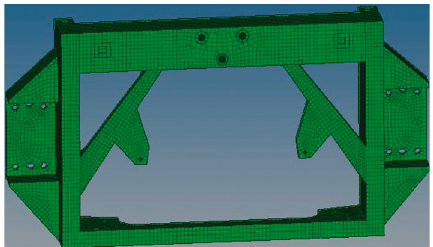
Figure 3: Front-end framework shape optimization results.